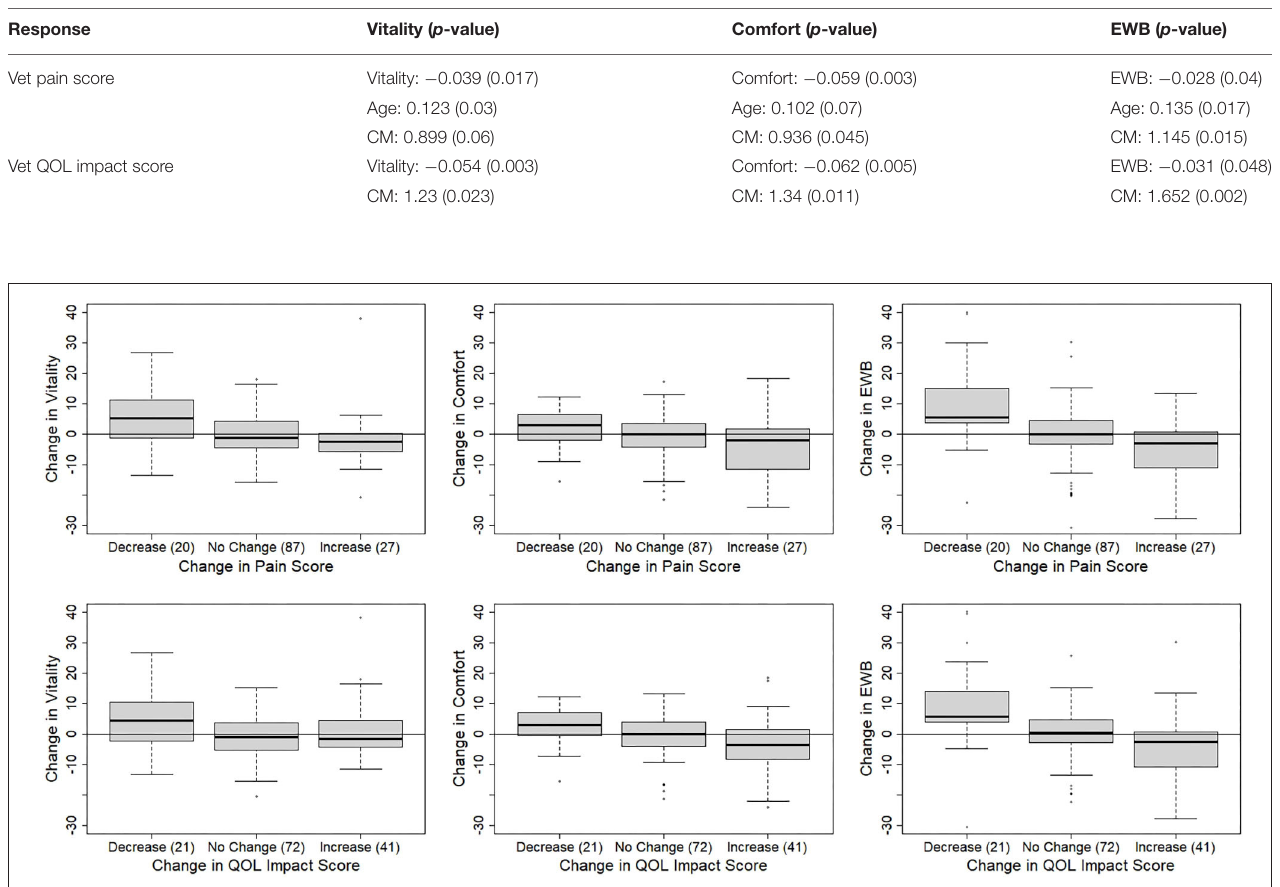
TABLE 5 | Changes in health-related quality of life domain scores, Vitality, Comfort and Emotional Wellbeing (EWB) with respect to change in vet-assessed pain score (VAP) and vet-assessed QOL impact score (VQOLI). HRQL Score Decrease in VAP No Change in VAP